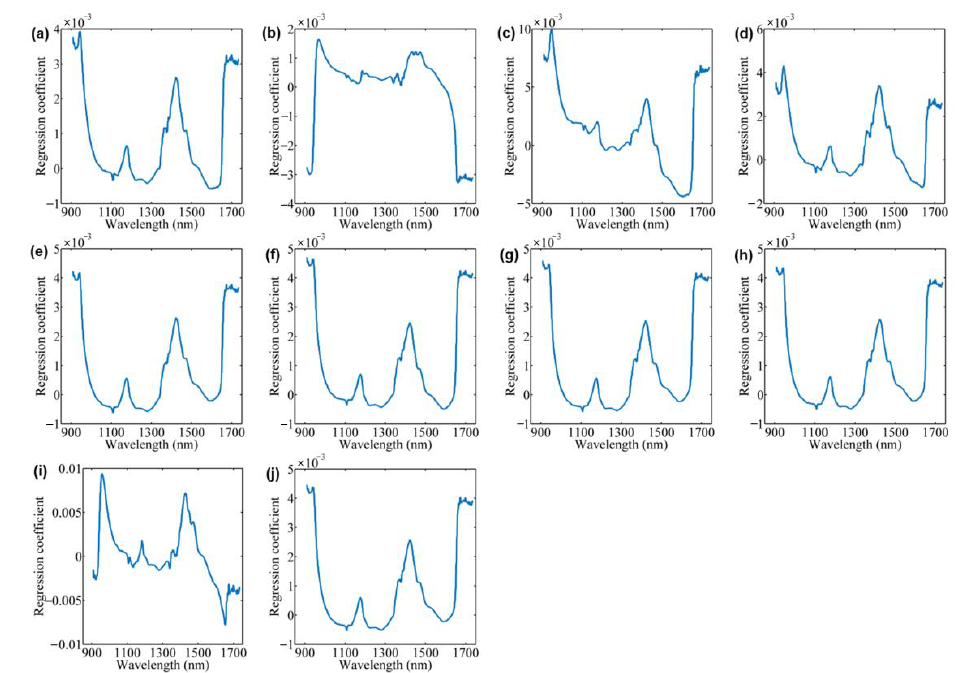
Figure 3. Regression coefficient plots of PLS models for the prediction of fatty acids: palmitic acid ( a ); stearic acid ( b ); arachidic acid ( c ); total saturated fatty acids ( d ); 9-hexadecenoic acid ( e ); oleic acid ( f ); linoleic acid ( g ); linolenic acid ( h ); cis-11-eicosenoic acid ( i ); and total unsaturated fatty acids ( j ).